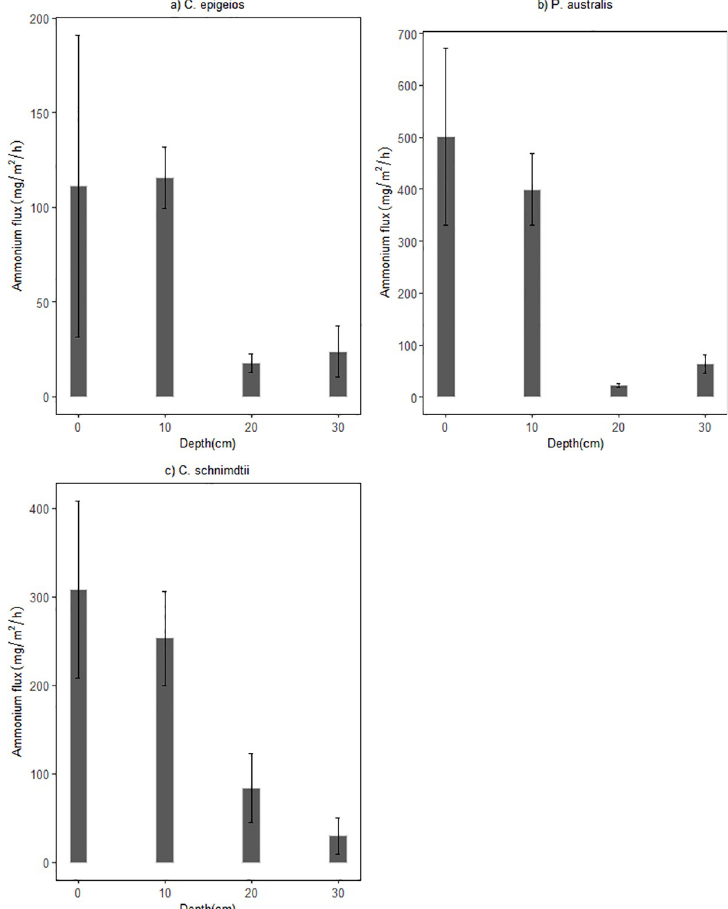
Fig 6. Hourly fluxes of surface water NH þ at different soil depths in laboratory setup incubated for 30 days. (a) 4 Soil from site dominated by C . epigeios , (b) soil from site dominated by P . australis , (c) soil from site dominated by C . schnimdtii . Error bars represent standard error of the